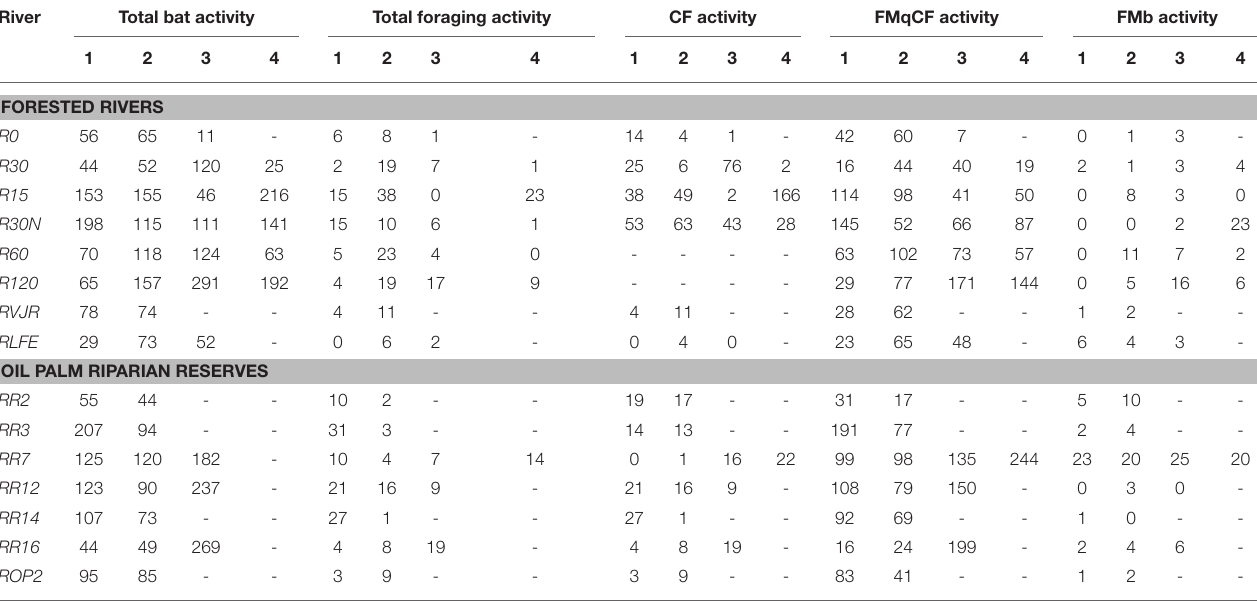
TABLE 1 | Bat activity and foraging activity alongside rivers sampled at the SAFE project Sabah.